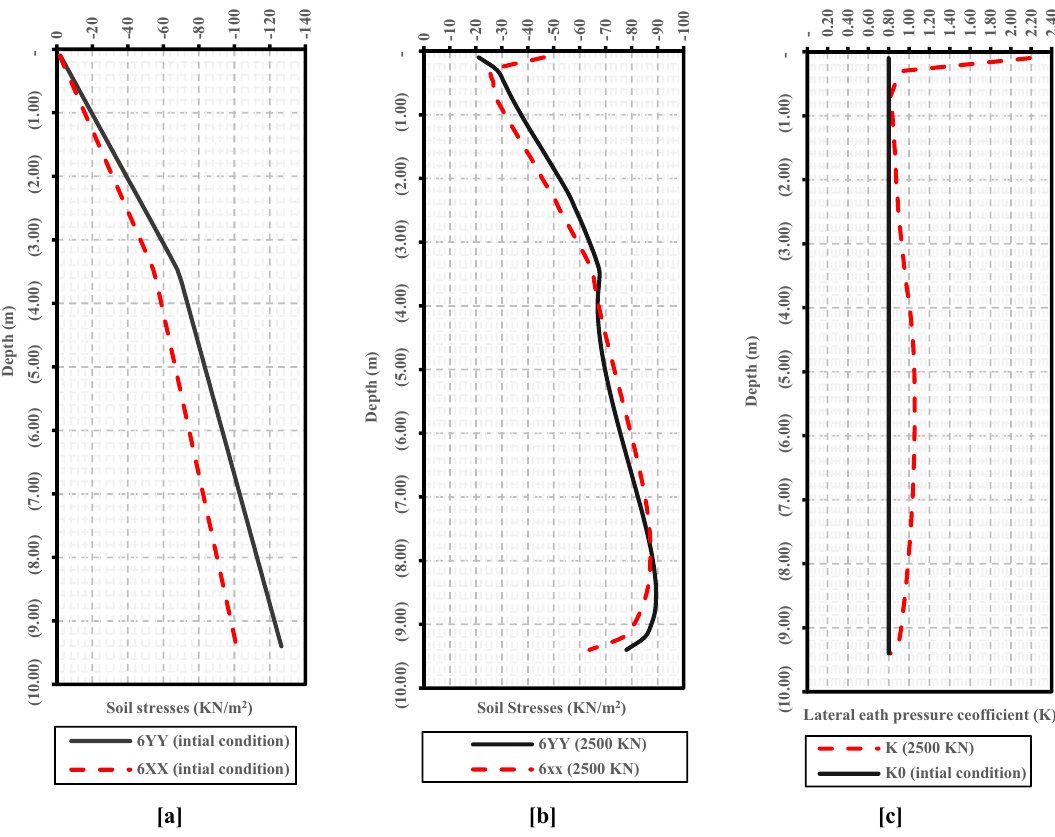
Figure 3. Finite element results of soil stress distribution with depth (After Ezzat et al. 37 ). ( a ) Vertical and horizontal soil stress distribution with depth at the initial condition. ( b ) Vertical and horizontal soil stress distribution with depth after full mobilization. ( c ) Lateral earth pressure coefficient at the initial condition (K 0 ) and after full mobilization.